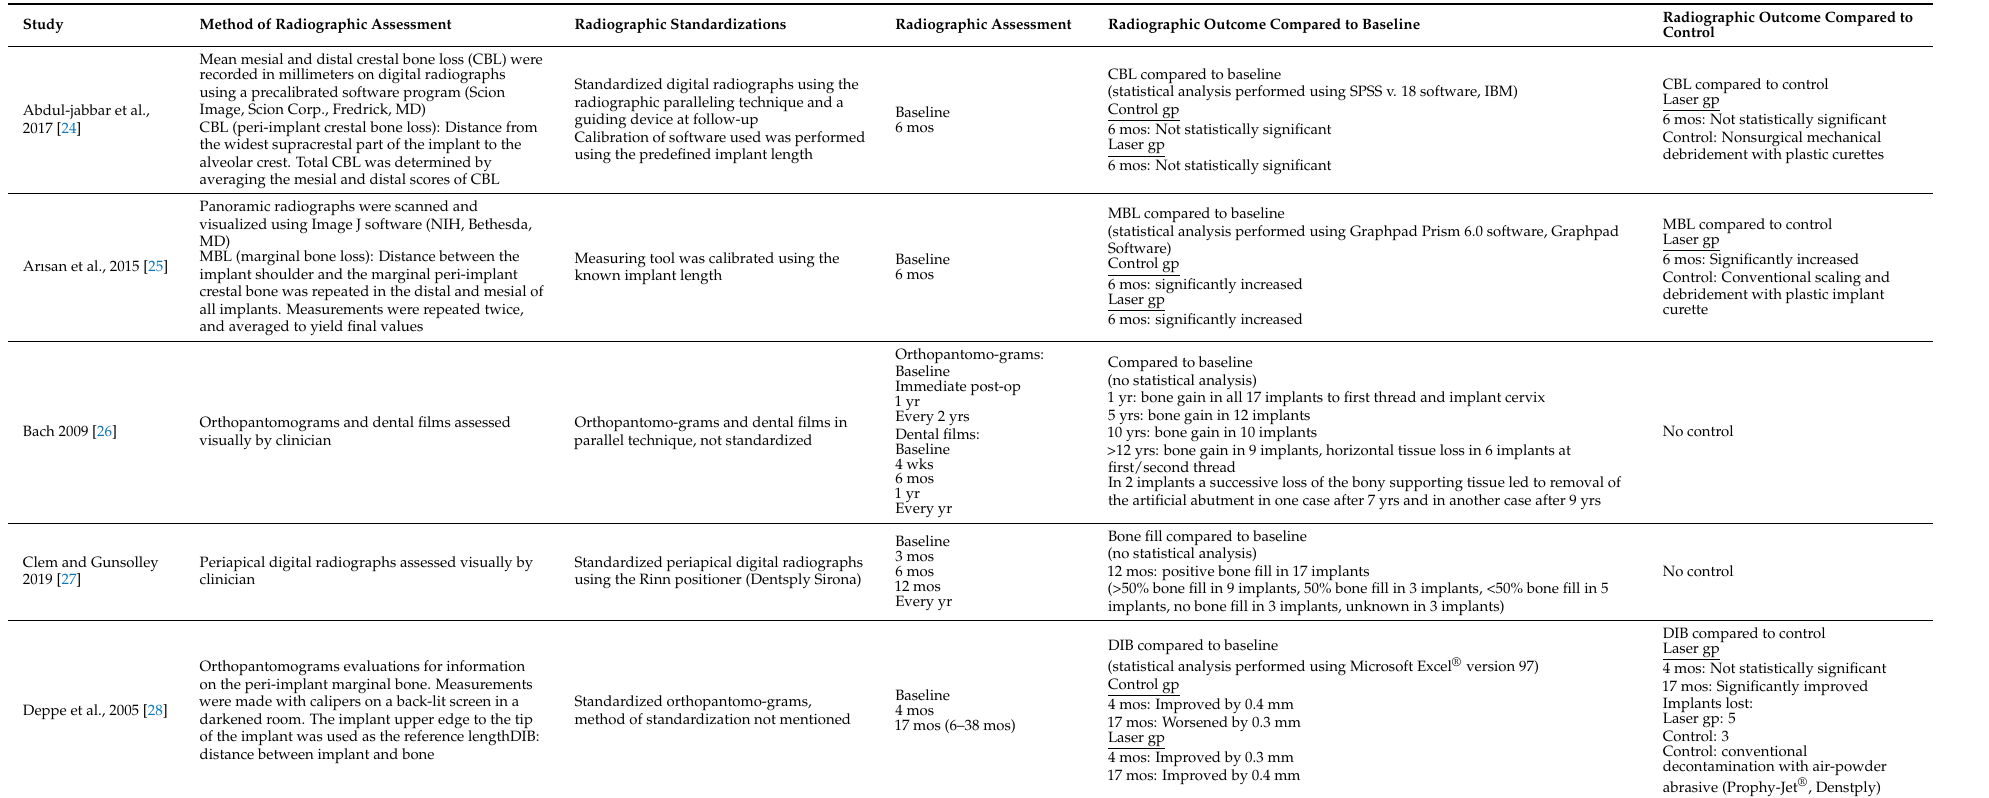
Table 6. Radiographic methods and outcomes.